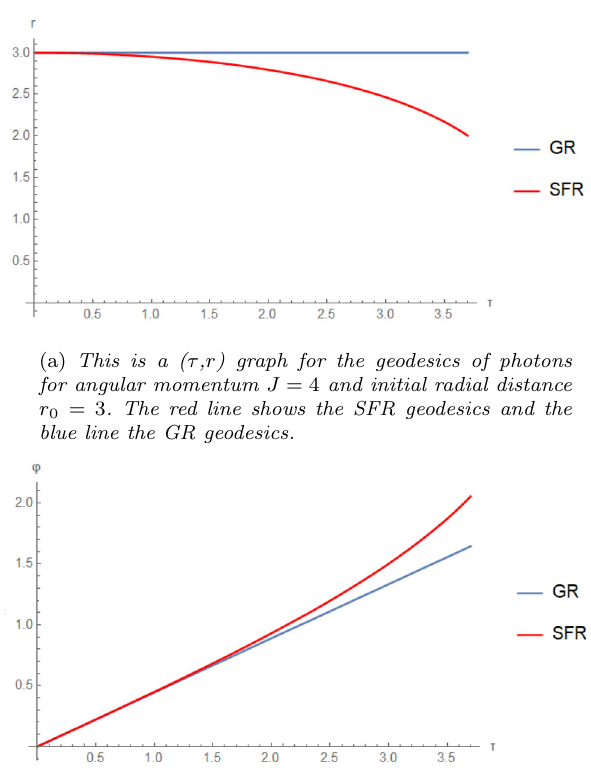
Fig. 1 These are the graphs for the GR and SFR geodesics of photons for angular momentum J = 4 and initial radial distance r 0 = 3